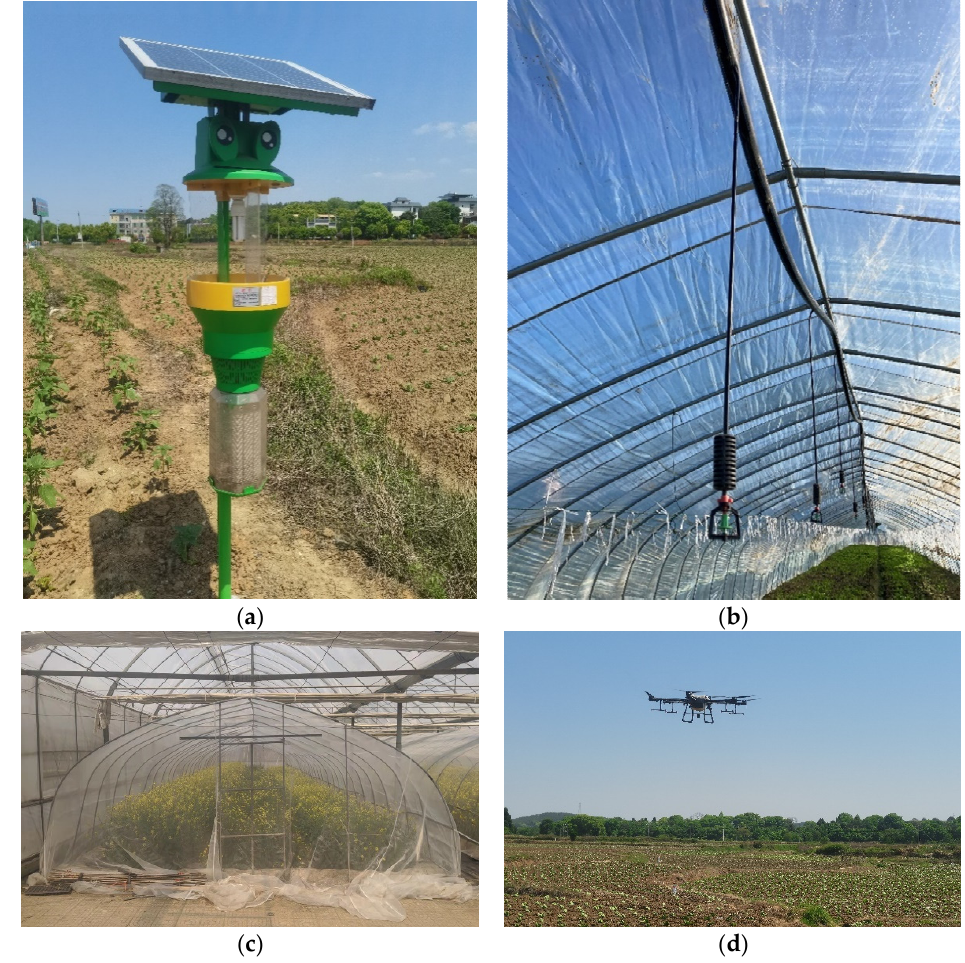
Figure 1. Related images to pesticide reduction technology. (Source: Photo by the author.). Note: ( a ) Light trapping technology (solar wind type insect trap for vegetable fields). ( b ) Healthy crop growth technology based on scientific water and fertilizer management (water and fertilizer sprinkler irrigation). ( c ) Insect-proof net technology (insect-proof net for vegetable greenhouses). ( d ) Drones apply biopesticides in tobacco field (Validamycin + Vivo-Bacillus cereus Mixture).